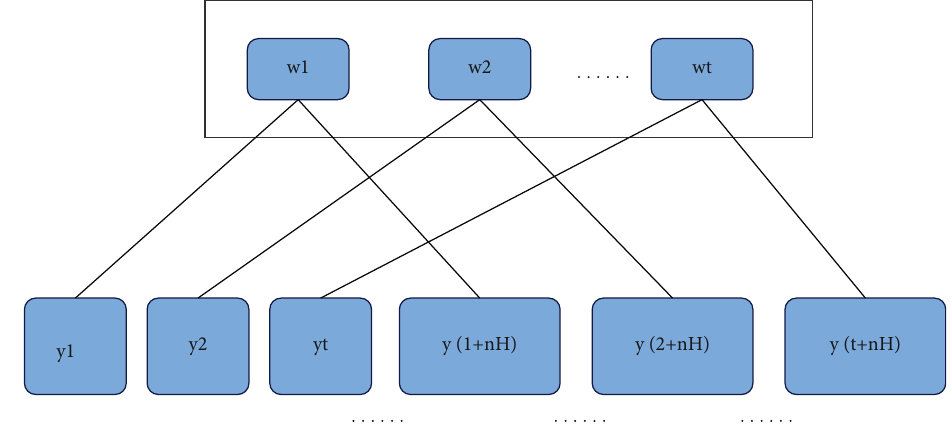
Figure 4: The effect of the periodic factor on the observation